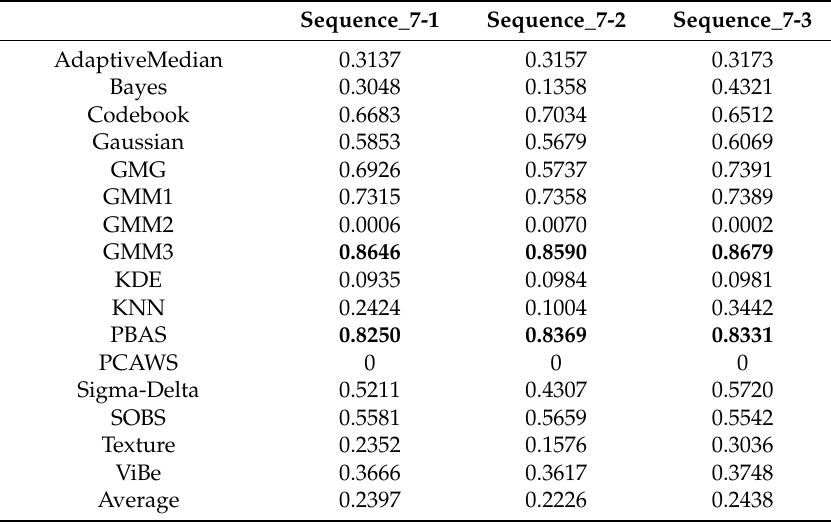
Table 17. Re s of the evaluated BS algorithms tested on Sequence_7